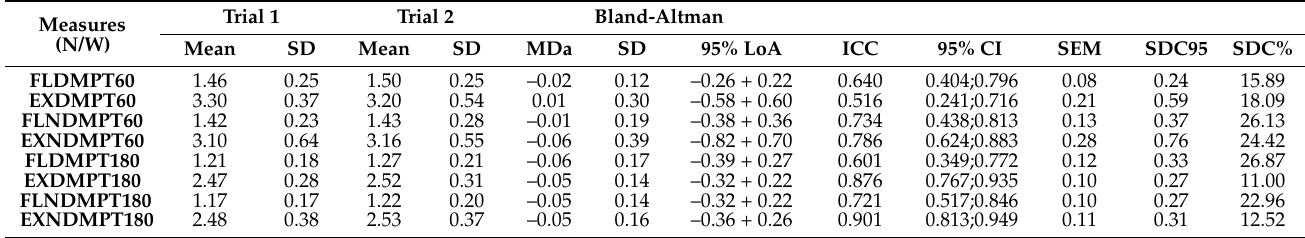
Table 4. Intra-rater reliability of new dynamometer.